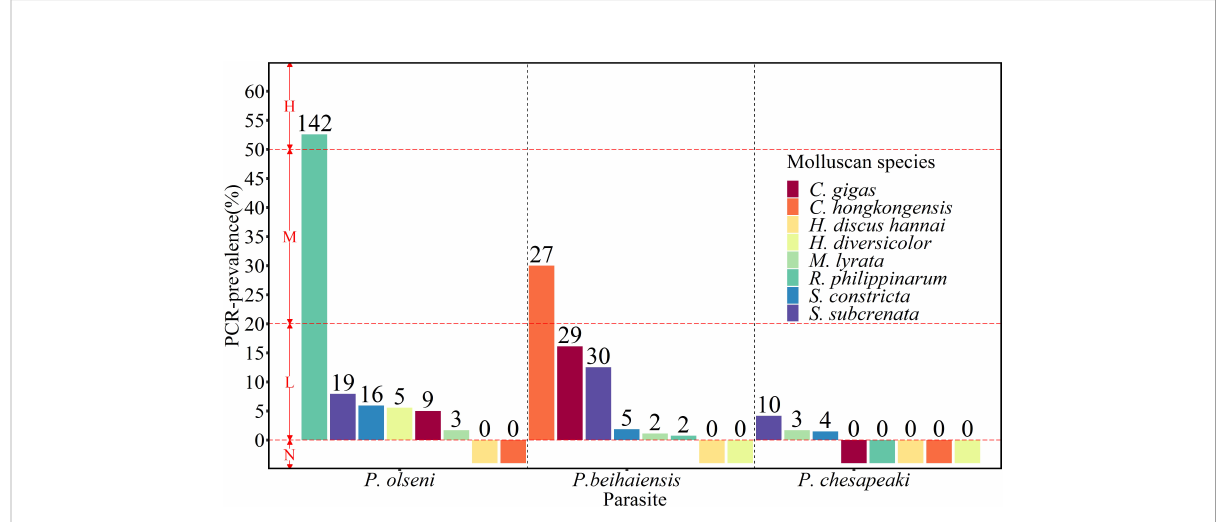
FIGURE 2 Perkinsus species diversity in different molluscan species in waters along the coast of China. Numbers above the bars indicate the total number of Perkinsus -carried individuals for each molluscan species. H: high PCR-prevalence grade; M: medium PCR-prevalence grade; L: low PCR- prevalence